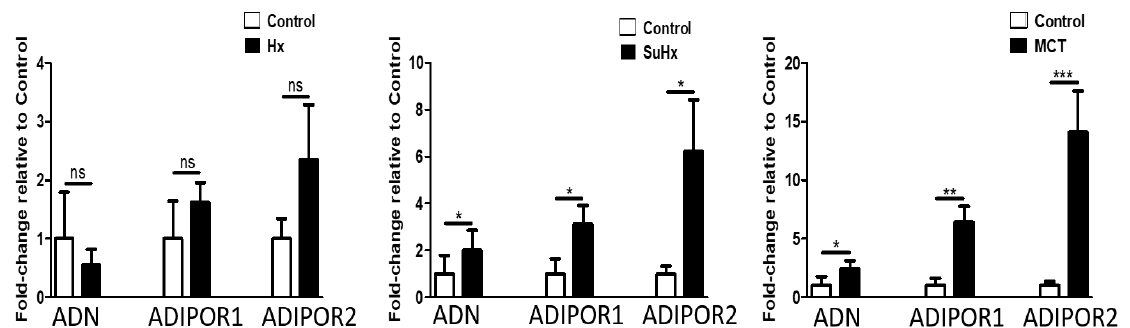
Figure 5. Altered adipose tissue levels of Adiponectin and Adiponectin receptor 1 and 2 mRNA in experimental pulmonary hypertension. Data represent mean ± SEM from n = 8–14 animals per experimental group. Statistical analysis by Student’s t -test. * p < 0.05, ** p < 0.005, *** p < 0.001, ns: no significant.